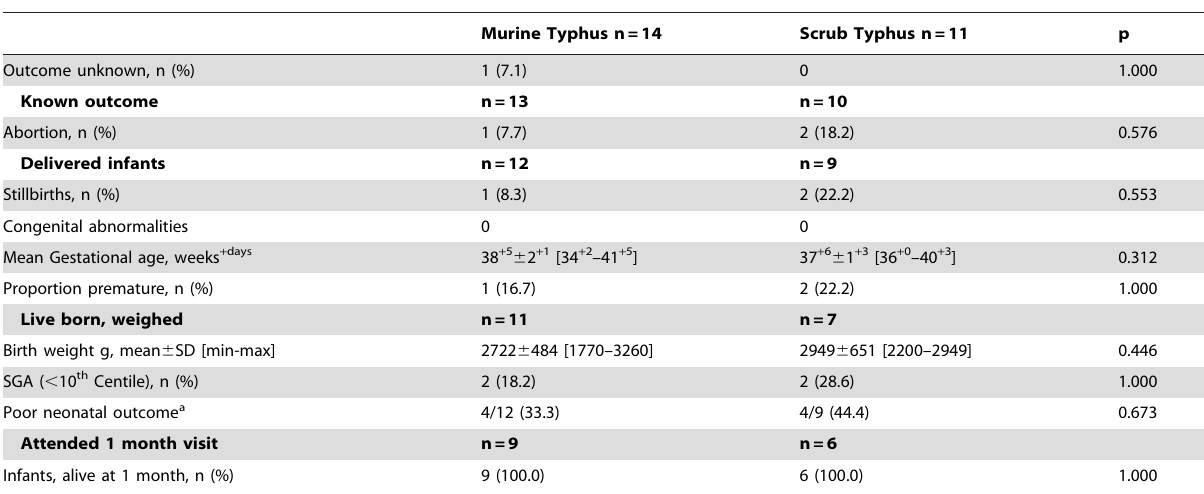
Table 3. SMRU fever cohort women pregnancy outcome by diagnostic